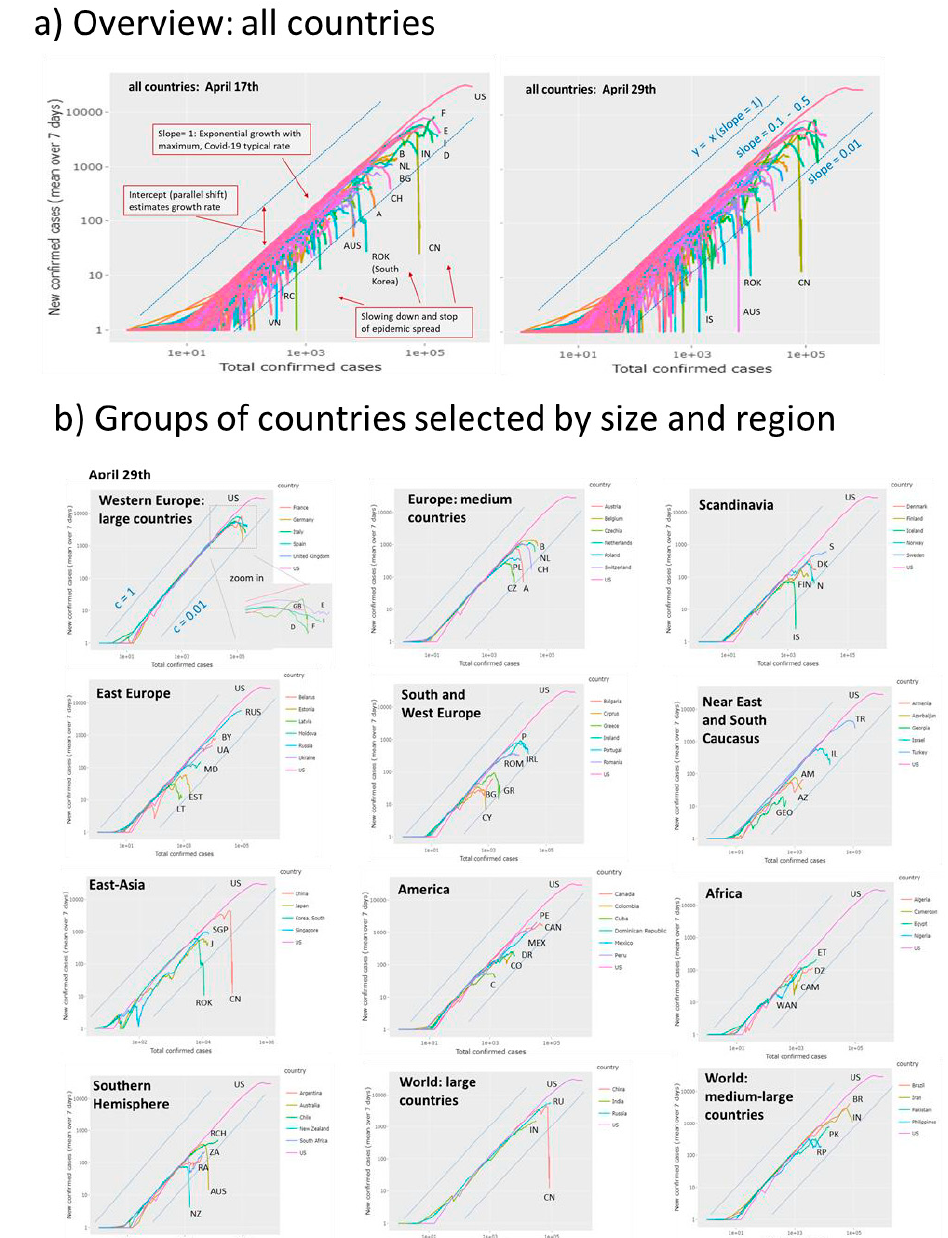
Figure 4. ‘Rise-and-fall’ trajectories of Covid-19 pandemic: ( a ) Trajectories of all 187 countries considered by Johns Hopkins Data Center plot new confirmed cases as a function of total cases in double logarithmic scale. They visualize the state of the epidemic with country-wise resolution. Exponential growth is reflected by a line parallel to the diagonal y = x (slope = 1) followed by a fall reflecting slowing down of the epidemic. The slope equals the difference between the transmission and removal rate factors, c–k. The slope = 0.01 line consequently refers to the more as tenfold reduction of the maximum transmission rate observed for many countries in their linear rising part. With time (compare left and right plots) the number of countries crossing this line increases. ( b ) Trajectories for groups of countries characterize the epidemic in countries of different population sizes and regions of the world. Trajectory of the USA (with the highest infection numbers worldwide) is shown for comparison in all plots. Letter codes for countries were chosen according to the international vehicle registration code (https://en.wikipedia.org/wiki/International_vehicle_ registration_code).